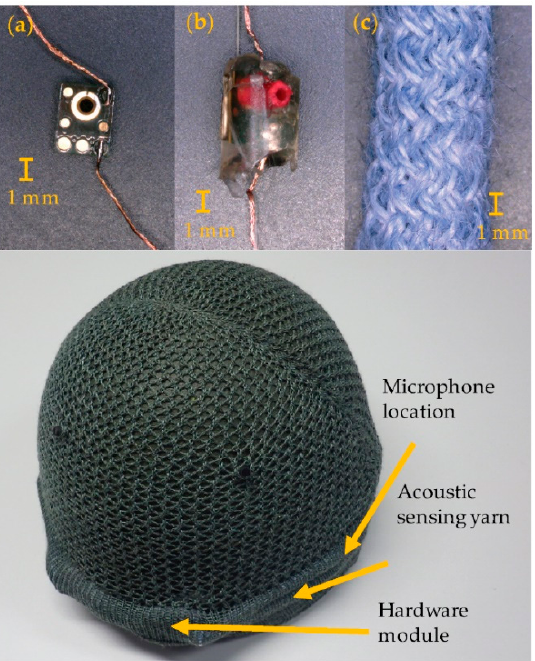
Figure 1. Images at different stages in the production of the prototype acoustic sensing helmet cover. ( a ) Soldered microphone; ( b ) encapsulated microphone; ( c ) final acoustic sensing yarn; ( Bottom ) Photograph of the rear of an acoustic sensing helmet cover prototype. The cover is on a British Army Mk6 helmet. Important components of the cover have been annotated.